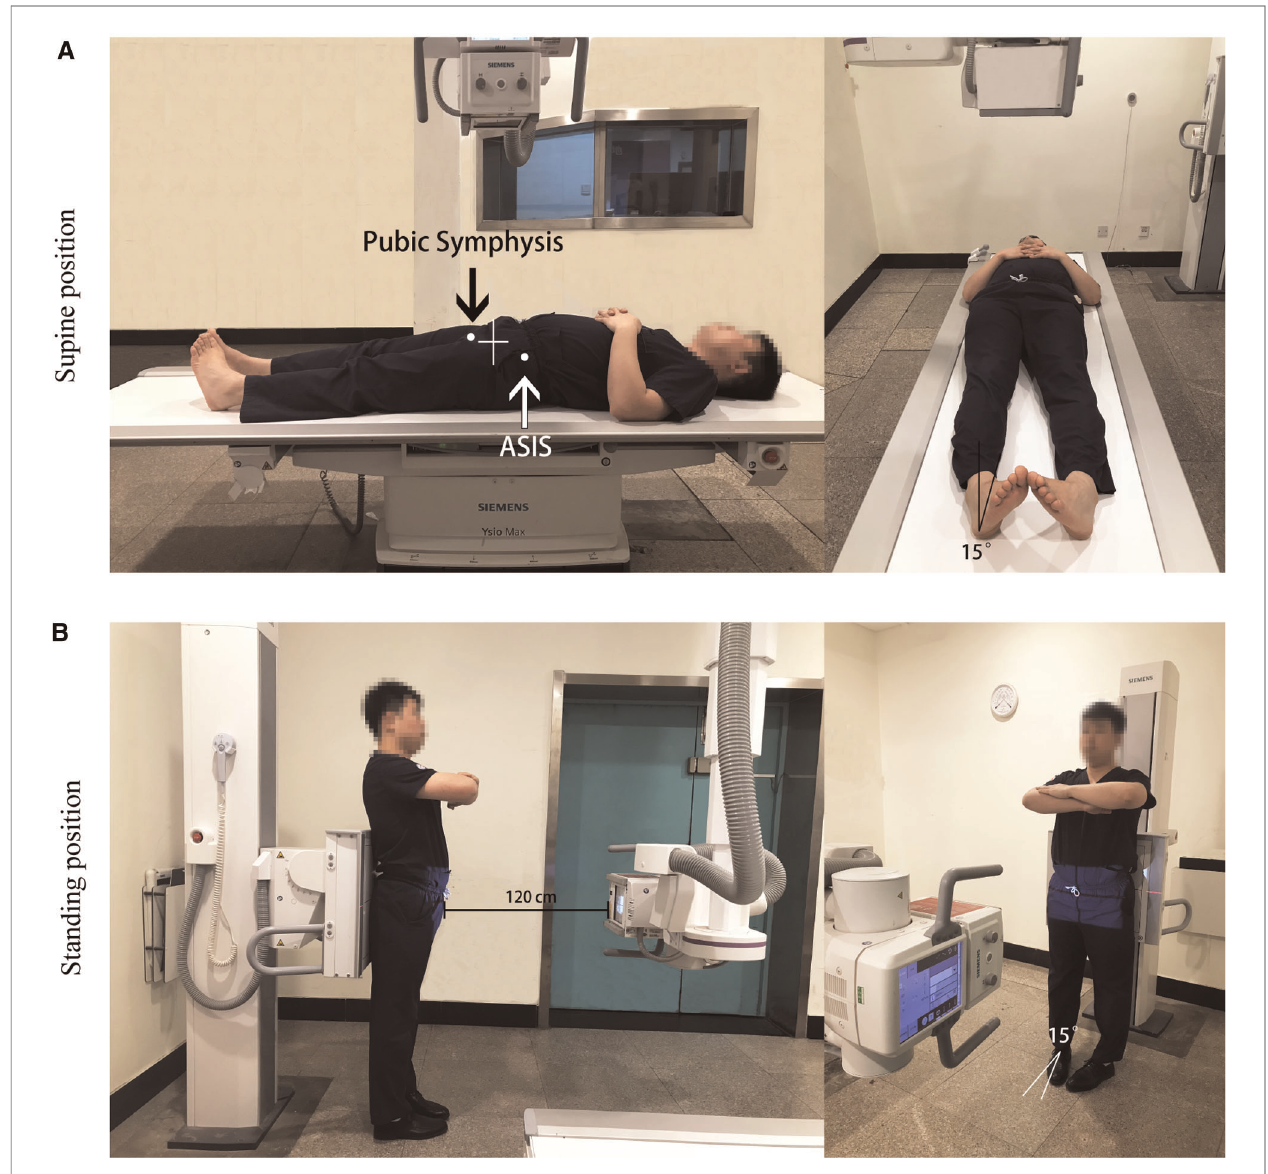
FIGURE 1 | Standard body positions of AP pelvic radiographs. ( A ) The AP pelvic radiographs of supine position. ( B ) The AP pelvic radiographs of standing position. ASIS is anterior superior iliac